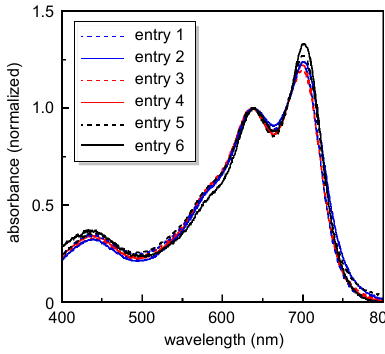
Figure 2. UV-vis spectra of poly( 1 - alt - 2 ) in thin film. The entry number follows Table 2. Table 2. Electronic properties of poly( 1 - alt - 2 ).